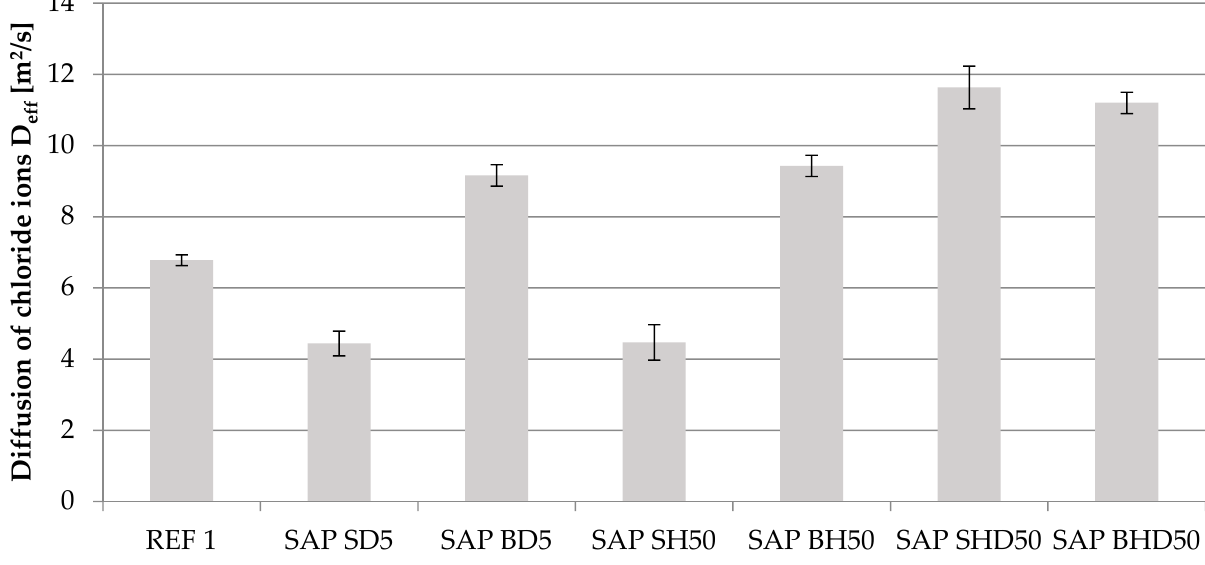
Figure 6. Coefficients of chloride ion diffusion for tested concrete series. The chloride diffusion lowered by approximately 30% compared to the REF 1 series of water-to-cement ratio of 0.4 for the SAP S-modified series that did not involve any extra water (from 6.78 × 10 − 12 m 2 /s for REF 1 to 4.44 × 10 − 12 m 2 /s for SAP SD5 and 4.47 × 10 − 12 m 2 /s for SAP SH50). The SAP SH50 series in which w/c tot was increased by 0.02 (the amount of water that was entrained in SAP) resulted in an increase of chloride ion diffusion coefficient by approximately 70% compared to the REF 1 series (an increase from 6.78 × 10 − 12 m 2 /s for the REF 1 series to 11.63 × 10 − 12 m 2 /s for the SAP SHD50